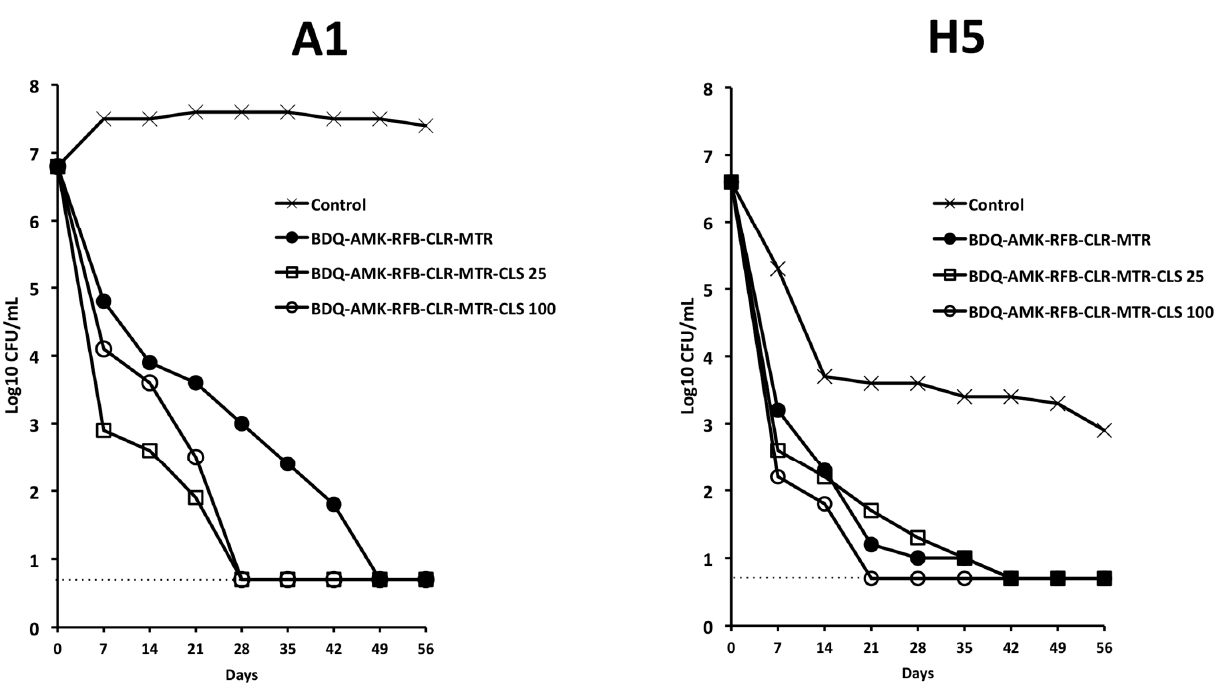
Figure 10. Activity against A1 and H5 cells of BDQ-AMK-RFB-CLR-MTR ±25 µg/mL or 100 µg/mL of CLS. Dashed lines indicate the limit of detection (5 CFU/mL). A representative experiment out of two is shown.